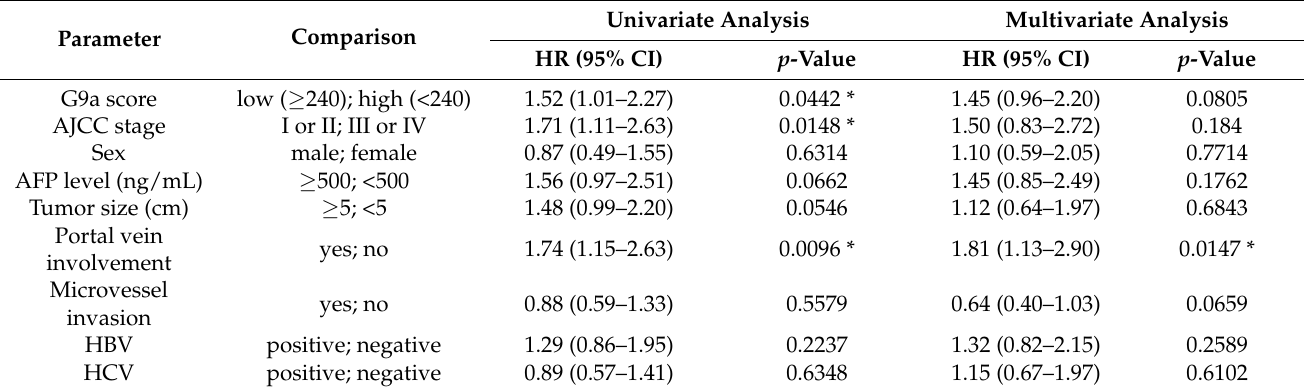
Table 2. Univariate and multivariate analyses of potential prognostic